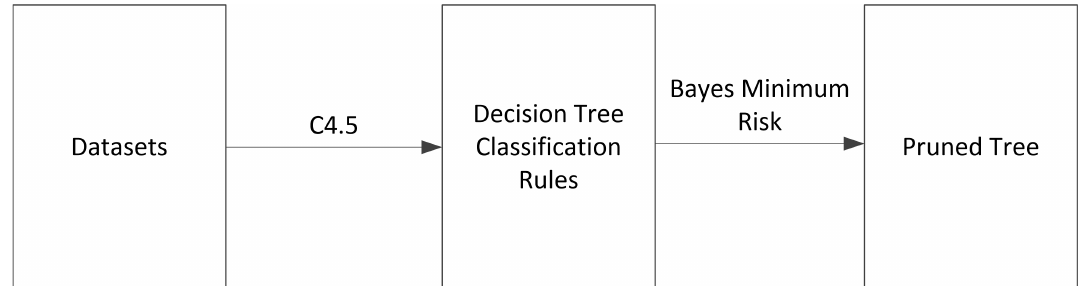
Fig 1. The principle of decision tree post-pruning algorithm based on Bayes minimum